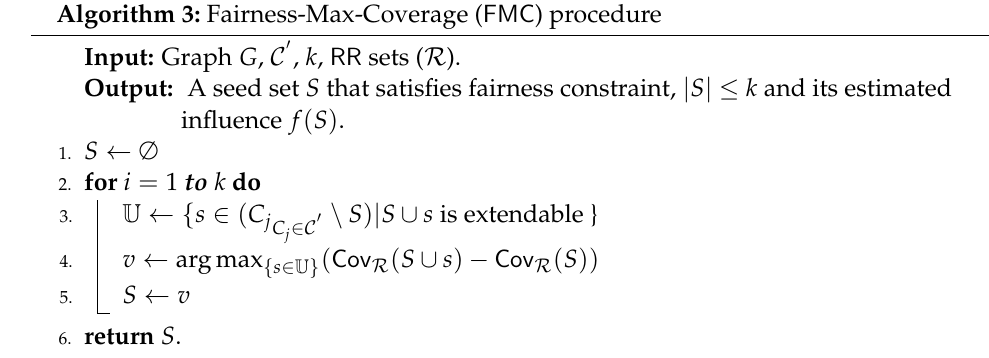
Algorithm 3: Fairness-Max-Coverage ( FMC )